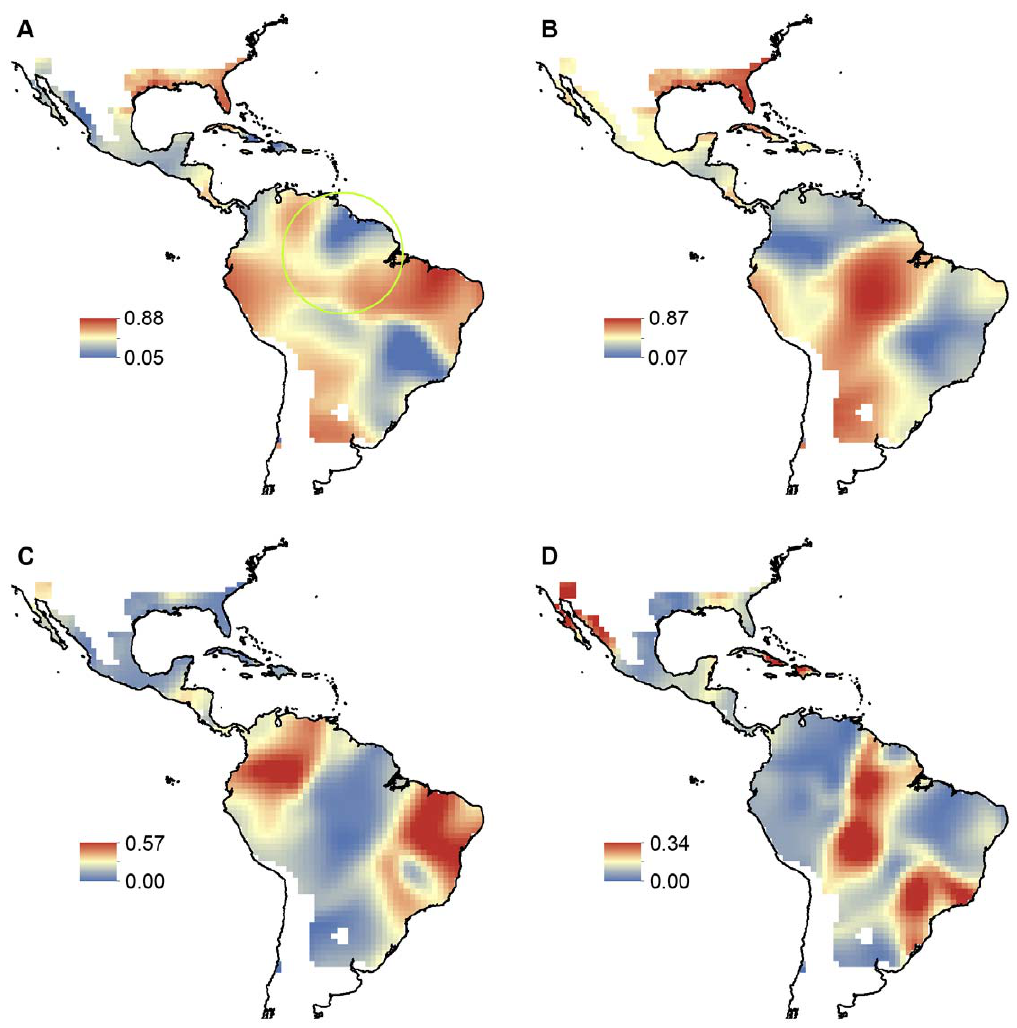
Figure 2. Variation in American palm species richness locally explained by water and energy. Local R 2 values obtained from geographically weighted regression (GWR) of palm species richness on annual precipitation, precipitation of the driest month, and water deficit (A) and mean annual temperature, minimum temperature of the coldest month, and potential evapotranspiration (B). Fraction of variation uniquely explained by the water variables (C) and energy variables (D) obtained from variation partitioning. The green circle in (A) shows the GWR bandwidth for a cell situated at the equator.